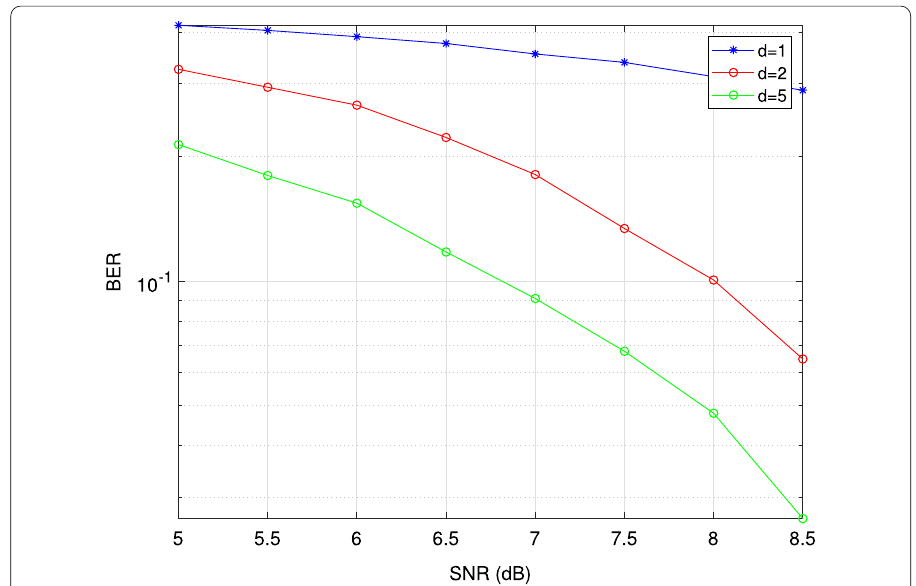
Fig. 5 BER performance comparison against SNR (dB) for d